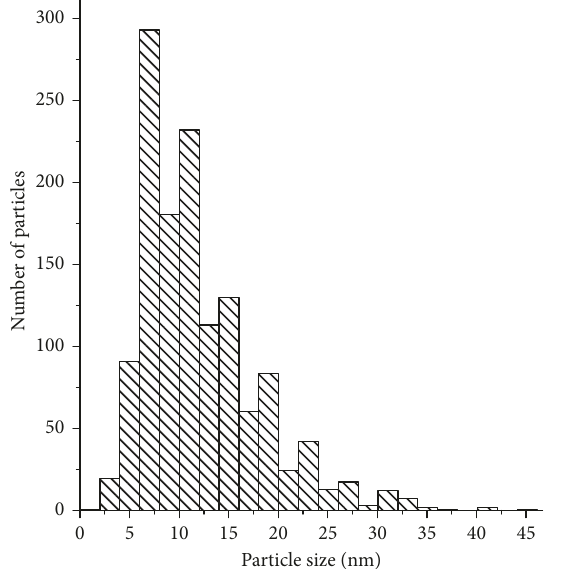
Figure 6: Histogram of the size